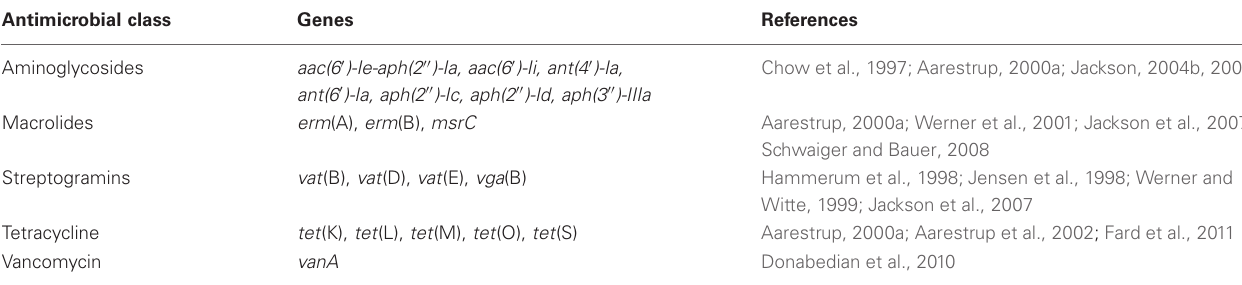
Table 4 | Antimicrobial resistance genes found in enterococci isolated from U.S. food animals. Antimicrobial